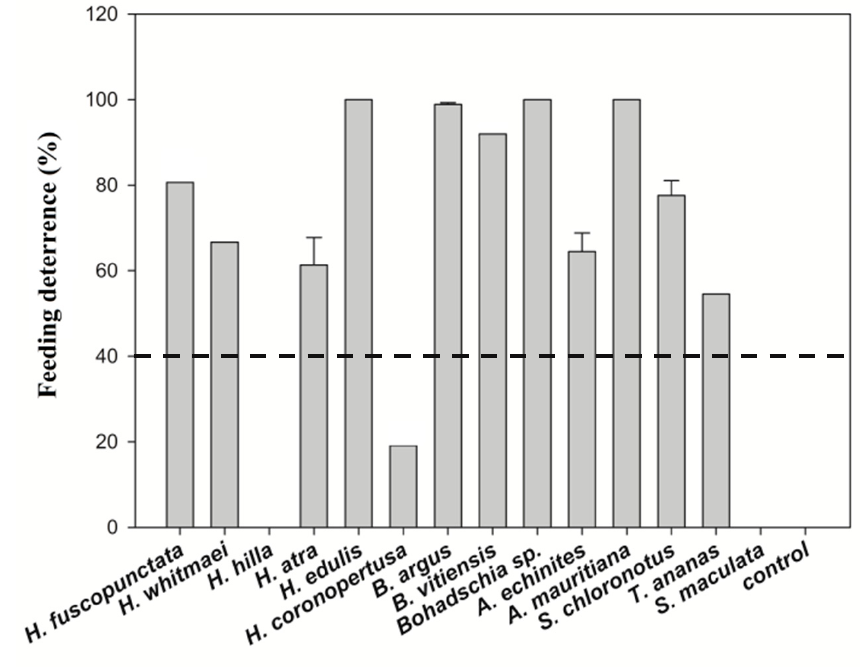
Figure 2. Percent feeding deterrent activity of sea cucumber crude extracts. The line at 40% indicates